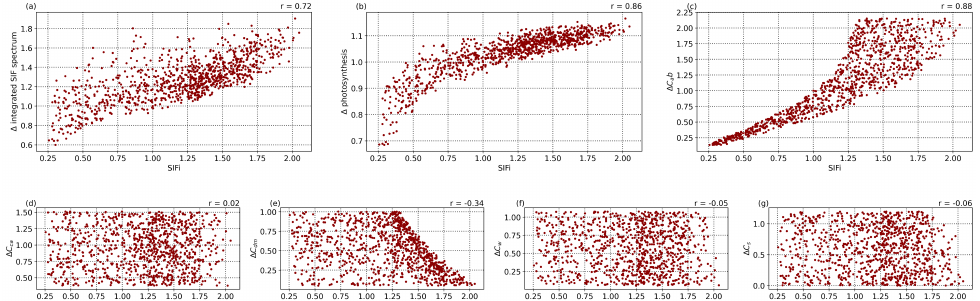
Figure 7. SCOPE simulations showing the correlations between the SIF indicator values calculated using Equation (9) and relative changes in: ( a ) the integrated solar induced fluorescence spectra, ( b ) photosynthesis rates, ( c ) chlorophyll AB content ( C ab ), ( d ) carotenoid content ( C ca ), ( e ) dry matter content ( C dm ), ( f ) leaf water equivalent layer ( C w ), and ( g ) senescent material fraction ( C s